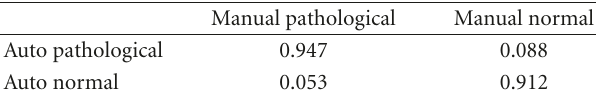
Table 2: Confusion matrix for the one correlation case (Training set).